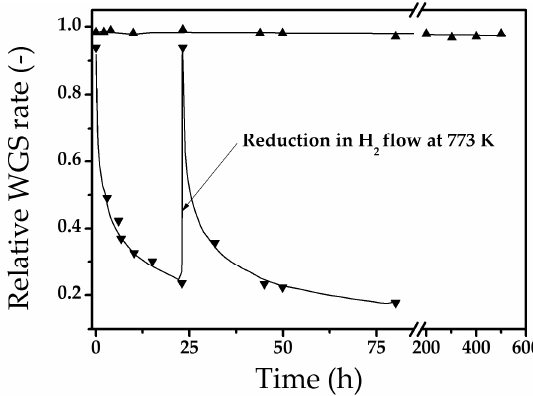
Figure 9. Stability of Mo 2 C/Mo composition ( ▲ ) compared with bulk Mo 2 C ( ▼ ) under water–gas shift (WGS) reaction conditions (same in Figure 8).